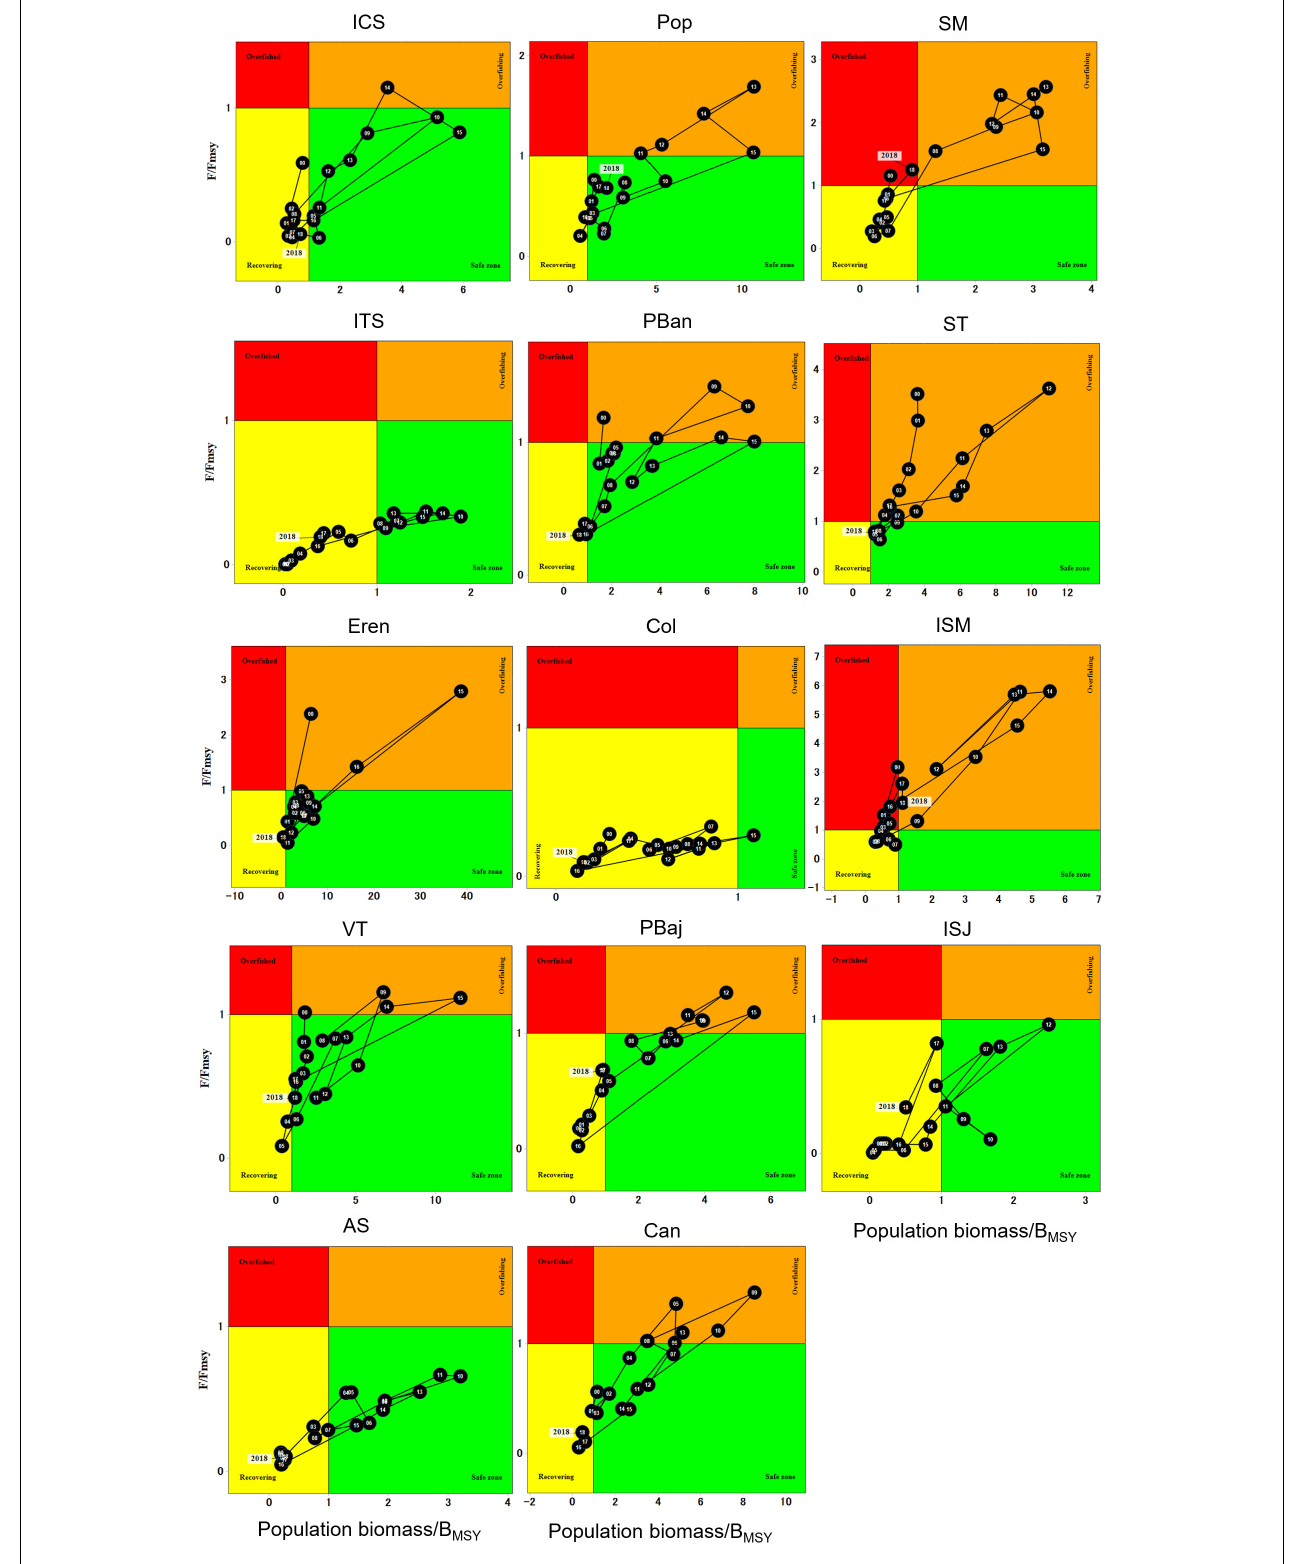
FIGURE 10 | Site-specific Kobe plots for red sea urchin population